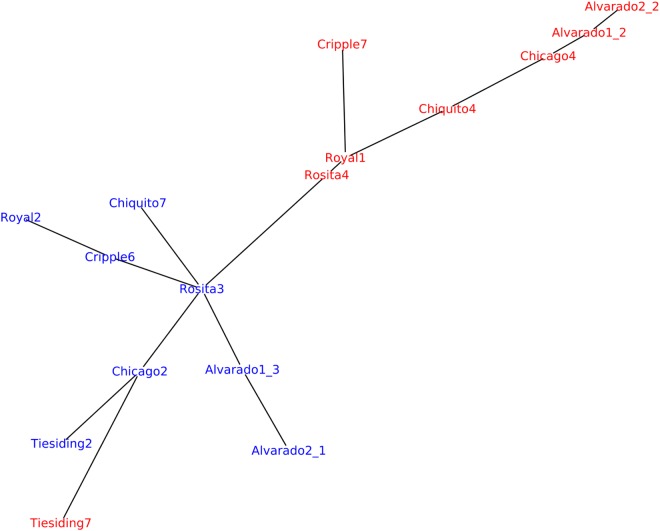
Replicating the analysis of B. spatioflia genetic structure variation (Lovell et al., 2017). Sequencing reads from 16 re-sequenced individuals (8 apomict-sexual sympatric pairs) were used to generate a minimum spanning network where edge length is proportional to Mash distance, which estimates the mutation rate between genomic sequences of B. spatiofolia individuals directly from their MinHash sketches (Ondov et al., 2016). Nodes represent sexual (blue) and apomictic (red) individuals.